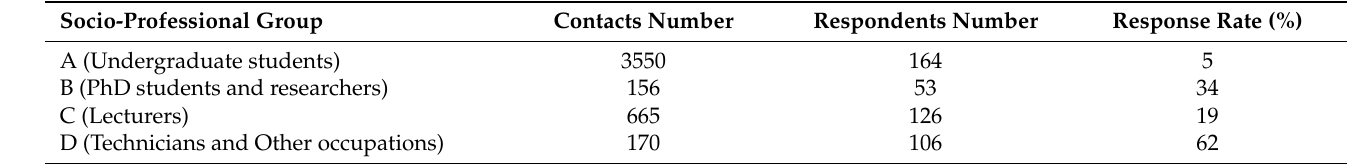
Table 3. Response rate obtained in this